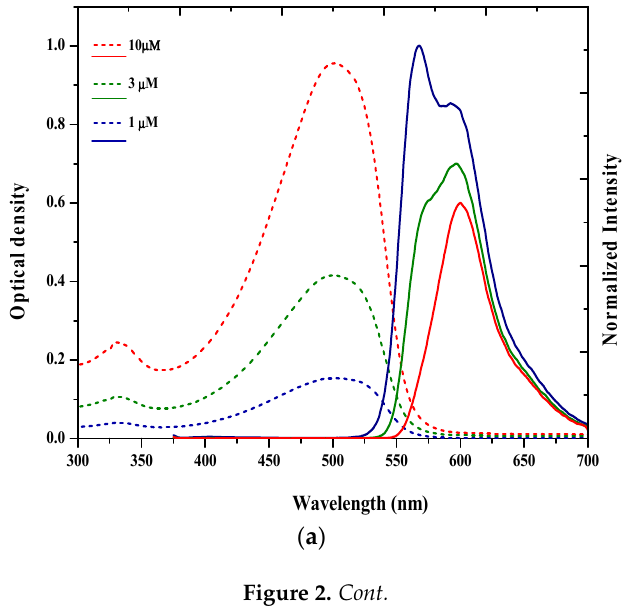
Figure 2. Cont. Figure 2.